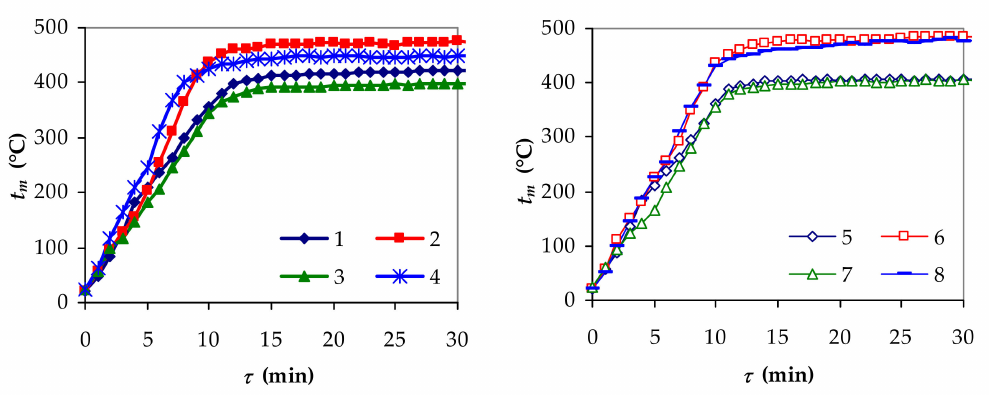
Figure 5. Mean temperature of fixed bed vine waste vs. time.